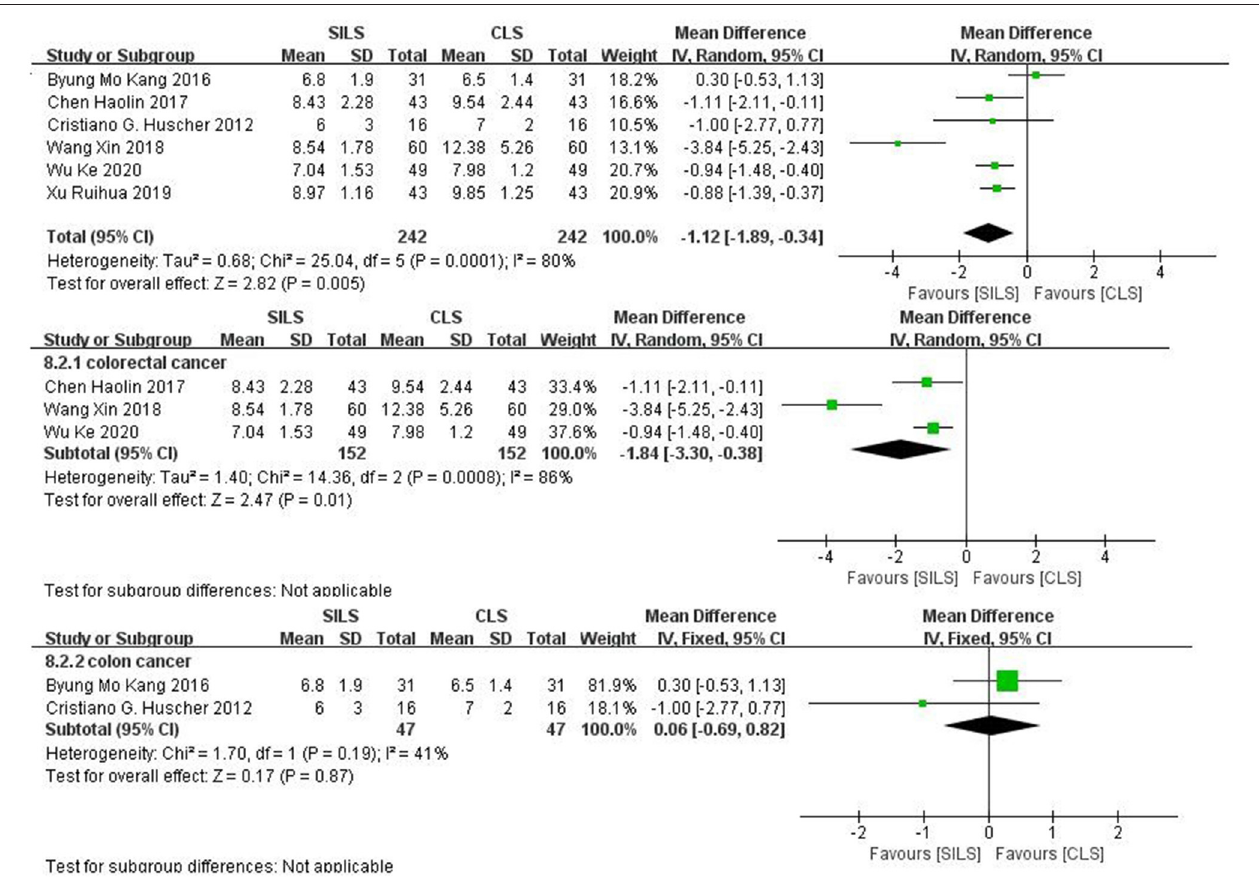
FIGURE 9 | Meta-analysis of length of hospital stay. SILS, single-incision laparoscopic surgery; CLS, conventional laparoscopic surgery.